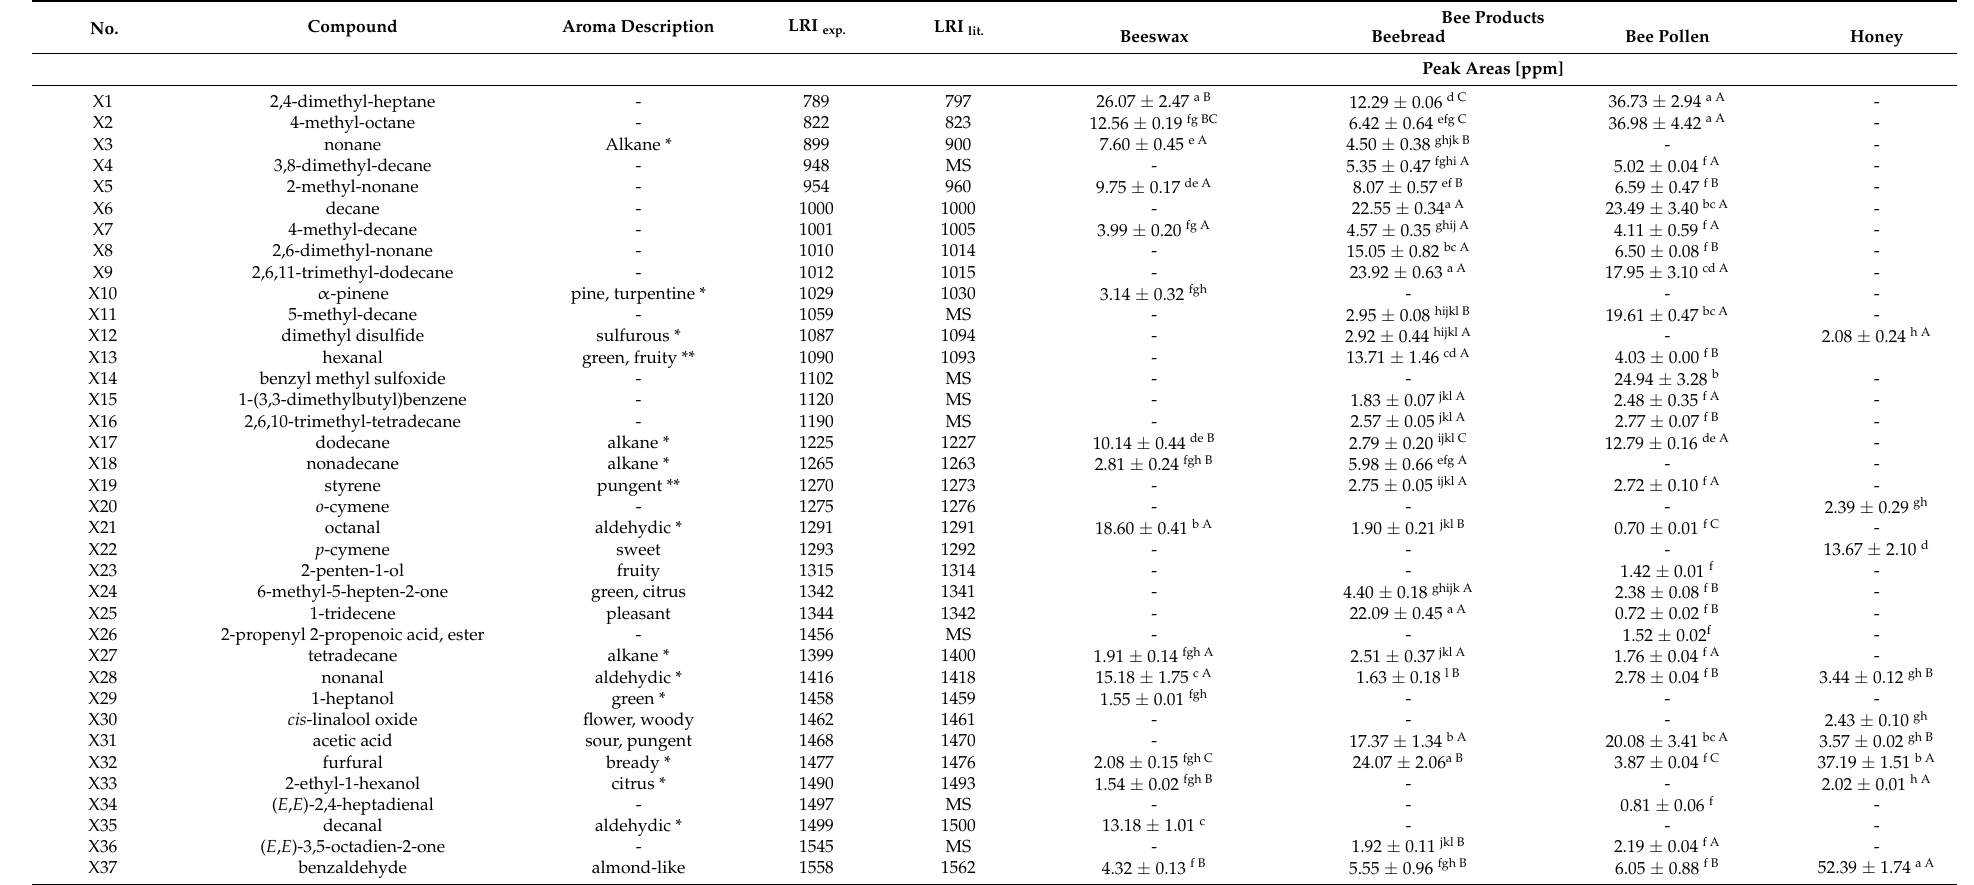
Table 1. The profile of volatile compounds identified in bee products with their potential aroma descriptions and relative abundance